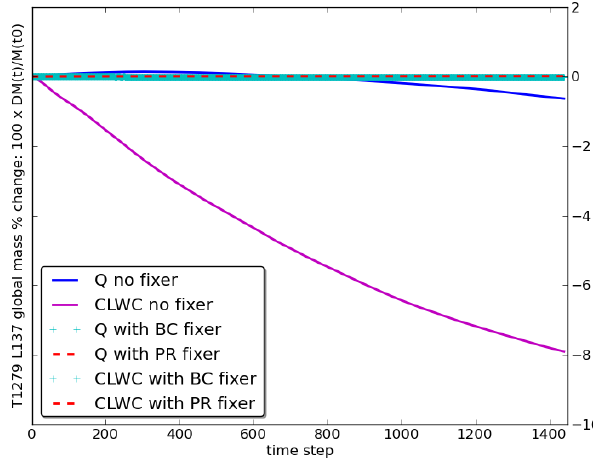
Figure 2. Mass conservation errors as a percentage of initial global Fig. 2. Mass conservation errors as a percentage of initial global mass for Q, CLWC at T1279 L137 resolution mass for Q, CLWC at T1279 L137 resolution forecast with/without PR and BC forecast with/without PR and BC MFAs.